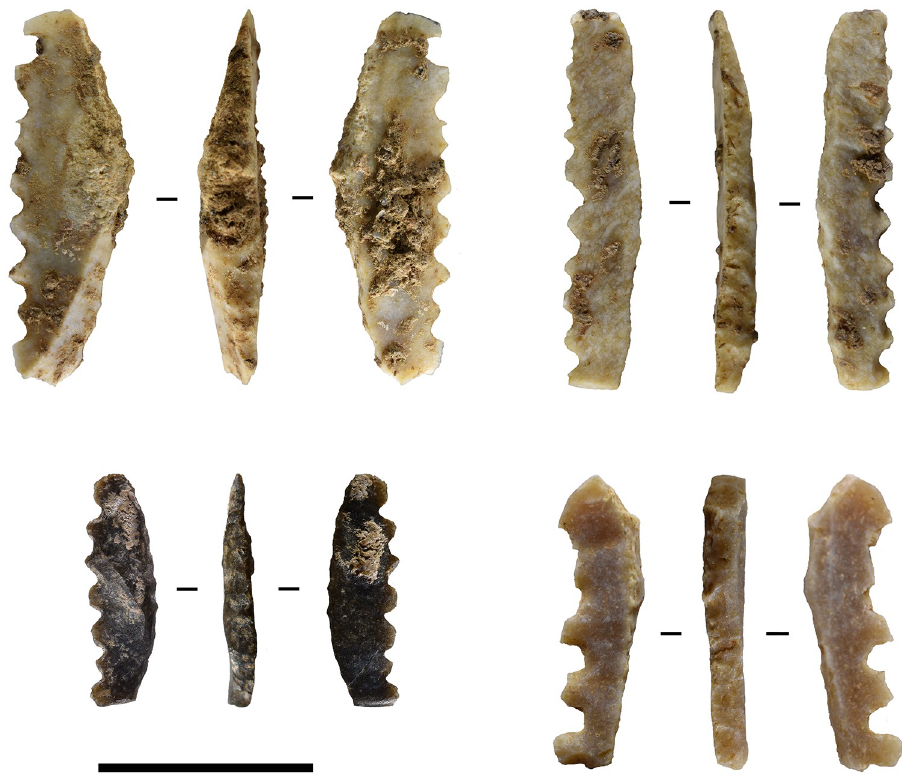
Fig 9. Leang Bulu’ Sipong sawlettes. Toalean ‘sawlettes’ recovered from the upper 40 cm of Leang Bulu’ Sipong 1, trench T9S1. Scale bar = 1 cm.